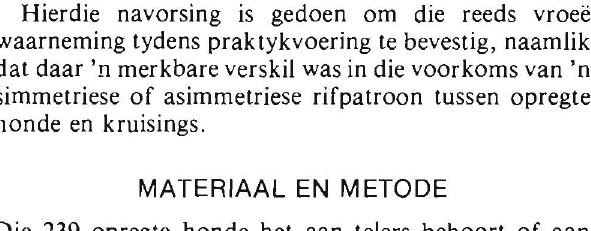
Fig. I is 'n voorbeeld van 'n simmetriese rifpatroon